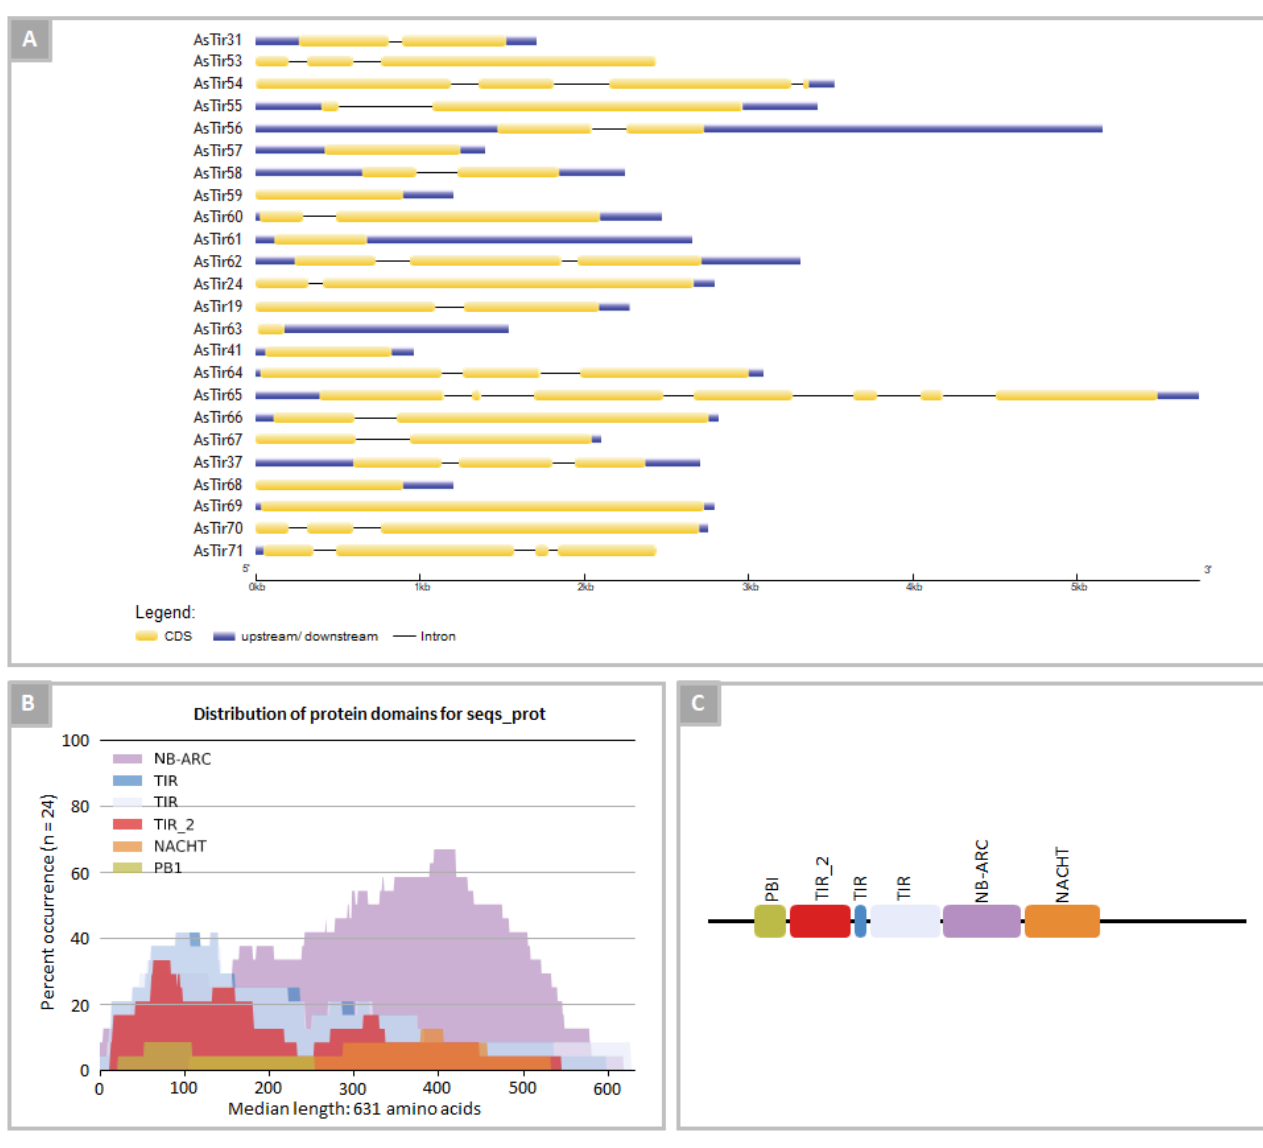
Figure 2. Gene and protein organization of TNx genes in A. stenosperma : ( A ) exon/intron organiza- tion of 24 TNx genes; ( B ) percentage of occurrence of conserved protein domains in TNx predicted proteins; ( C ) organization of conserved protein domains in TNx predicted proteins.